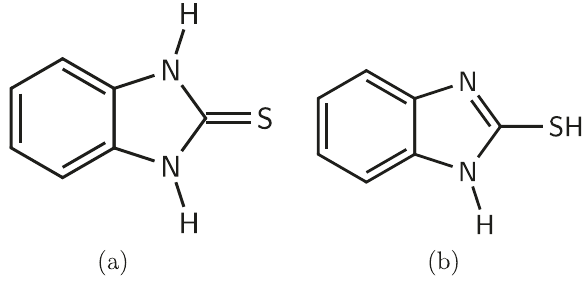
Fig. 1 Conformations of the 2-MBI molecule. a Thione form and b thiol form.